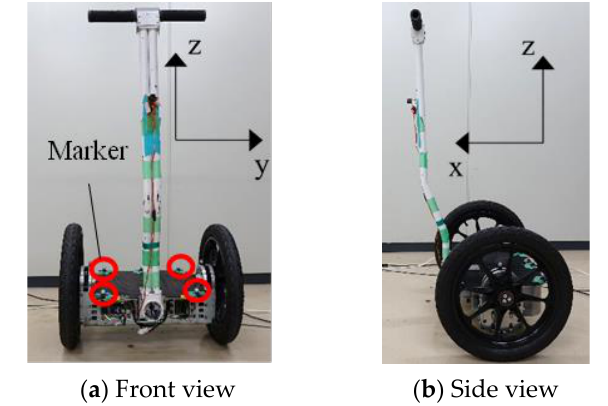
Figure 1. Experimental vehicle. Table 1. Specifications of the experimental vehicle.